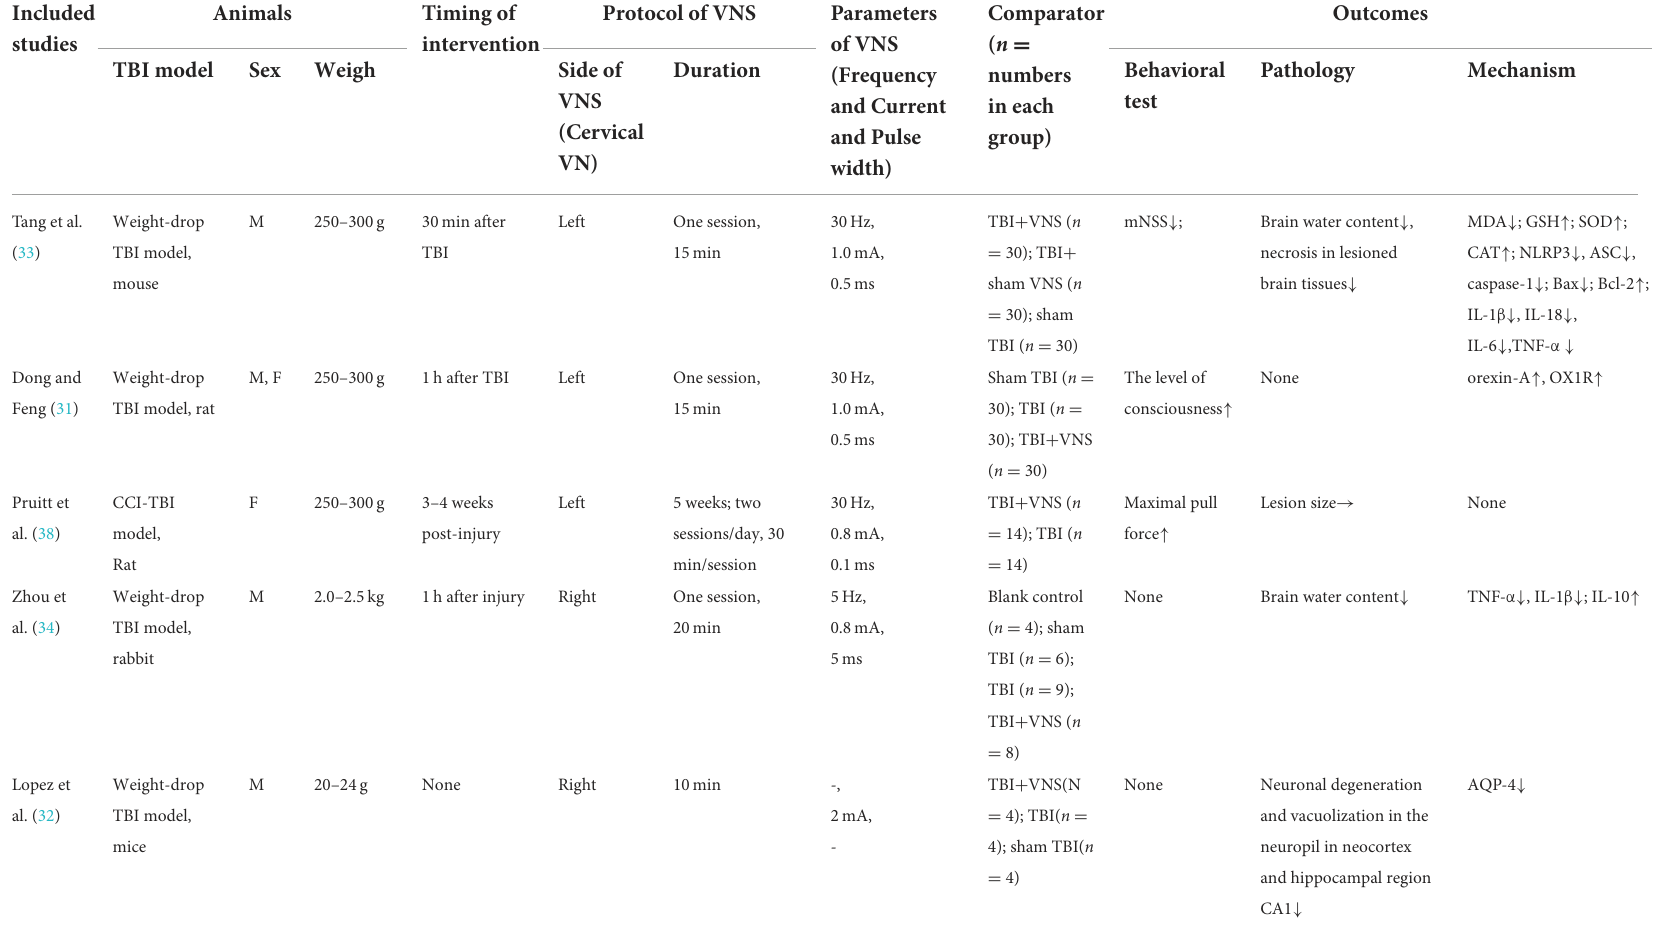
TABLE 2 Characteristics of the included